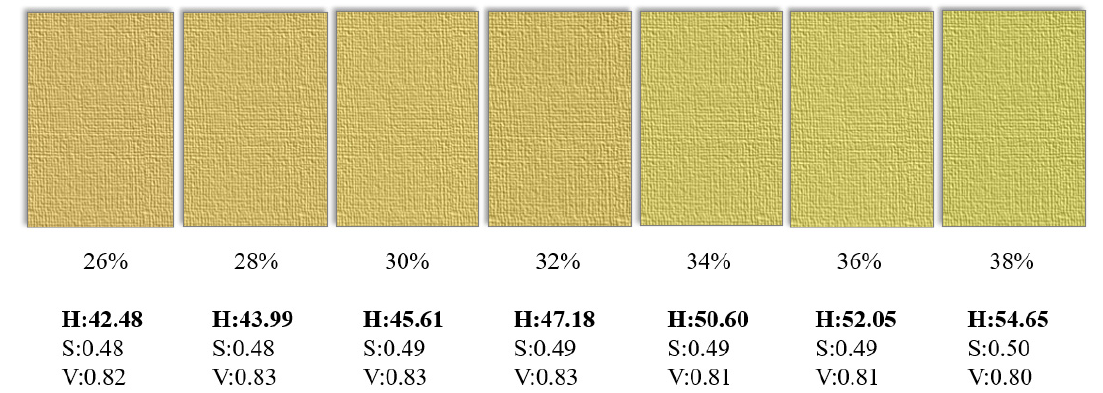
Figure 20. The schematic diagram of a panicle color board in term of HSV.